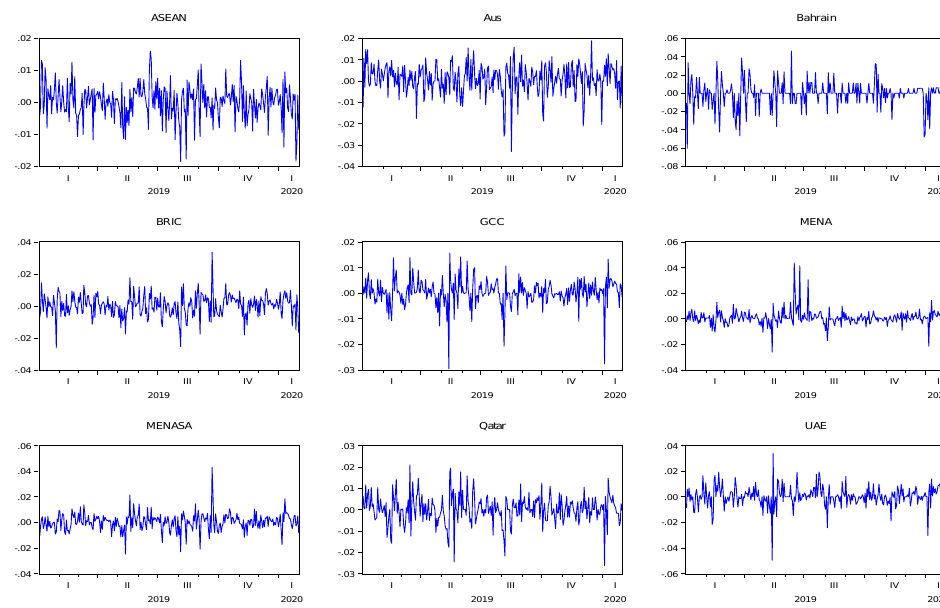
Figure A2. Full period. Source: authors’ calculation using EViews 10.